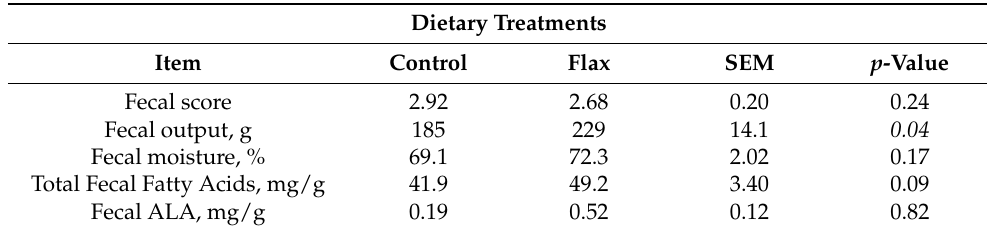
Table 3. Fecal score, total fecal output, fecal moisture, total fecal fatty acids, and fecal ALA in adult cats fed control and 2.6% as-is whole ground flaxseed